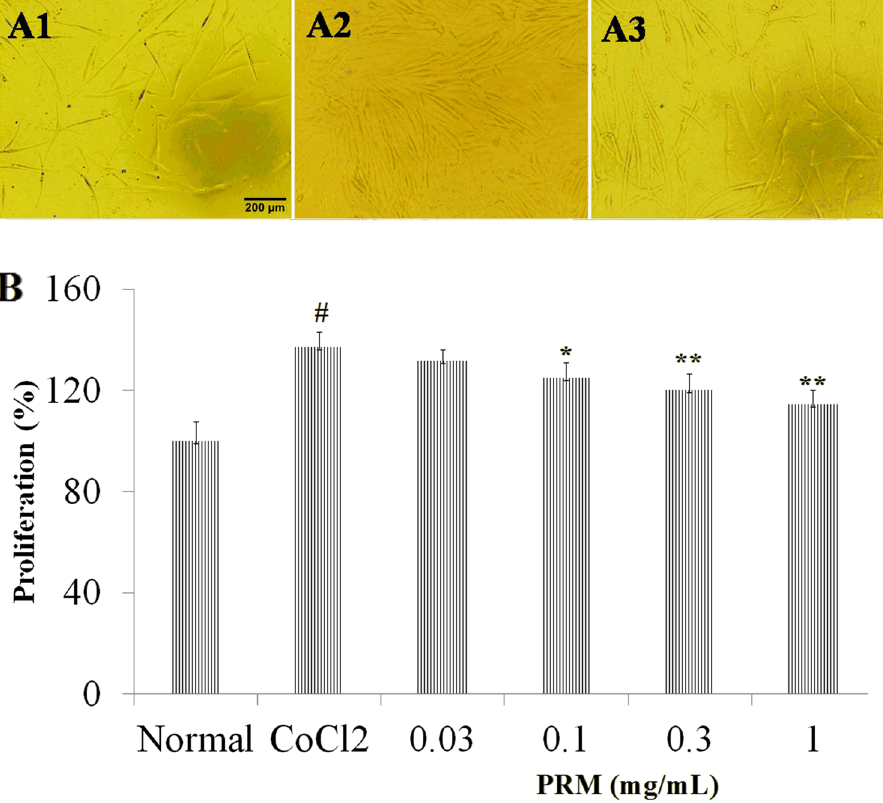
Figure 4. Effects of PRM on cell proliferation in HLF-1. ( A ) Cell proliferation was tested by MTT when HLF-1 cells were treated with CoCl 2 (100 μ M) for 48 h. All data was shown as the mean ± S.D., # P < 0.01 vs. the normal group; * P < 0.05, ** P < 0.01 vs. the CoCl 2 stimulated group. Significance was determined by one-way ANOVA followed by Dunnett’s